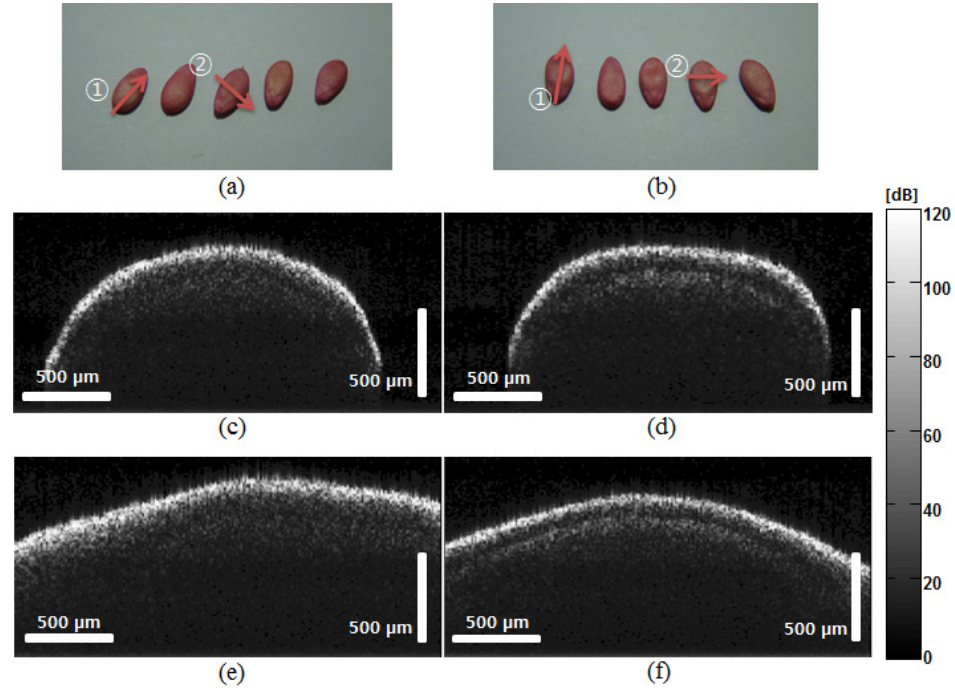
Figure 3. OCT B-mode scan comparison of normal and abnormal melon seeds, ( a ) and ( b ) are pictures of normal and abnormal melon seeds, respectively ( ① : lateral scan, ② : transverse scan), ( c ) and ( d ) are OCT images of normal and abnormal melon seeds, respectively, in the lateral direction; ( e ) and ( f ) are OCT images of normal and abnormal melon seeds, respectively, in the transverse direction. The scale bars mean in air. The pixel color indicates in a dB